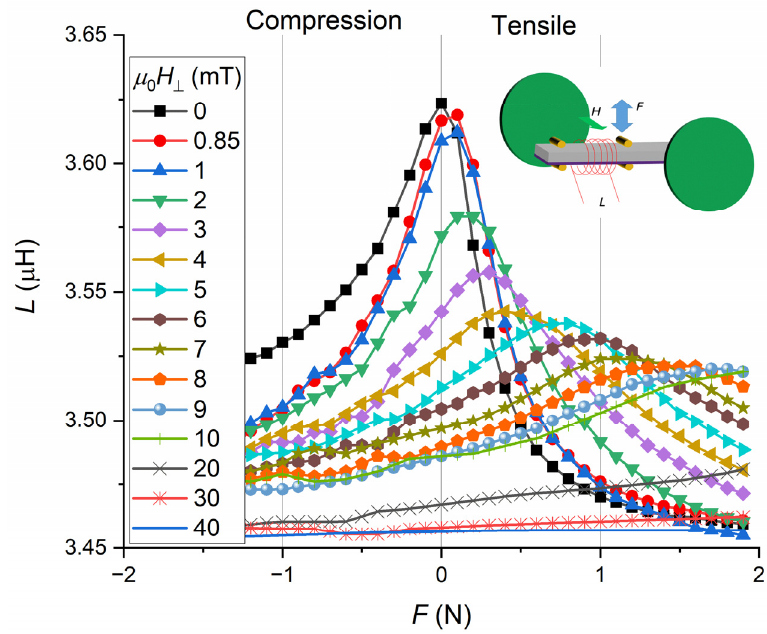
Figure 2. Measurement of the coil inductance versus the applied force with the applied orthogonal field.